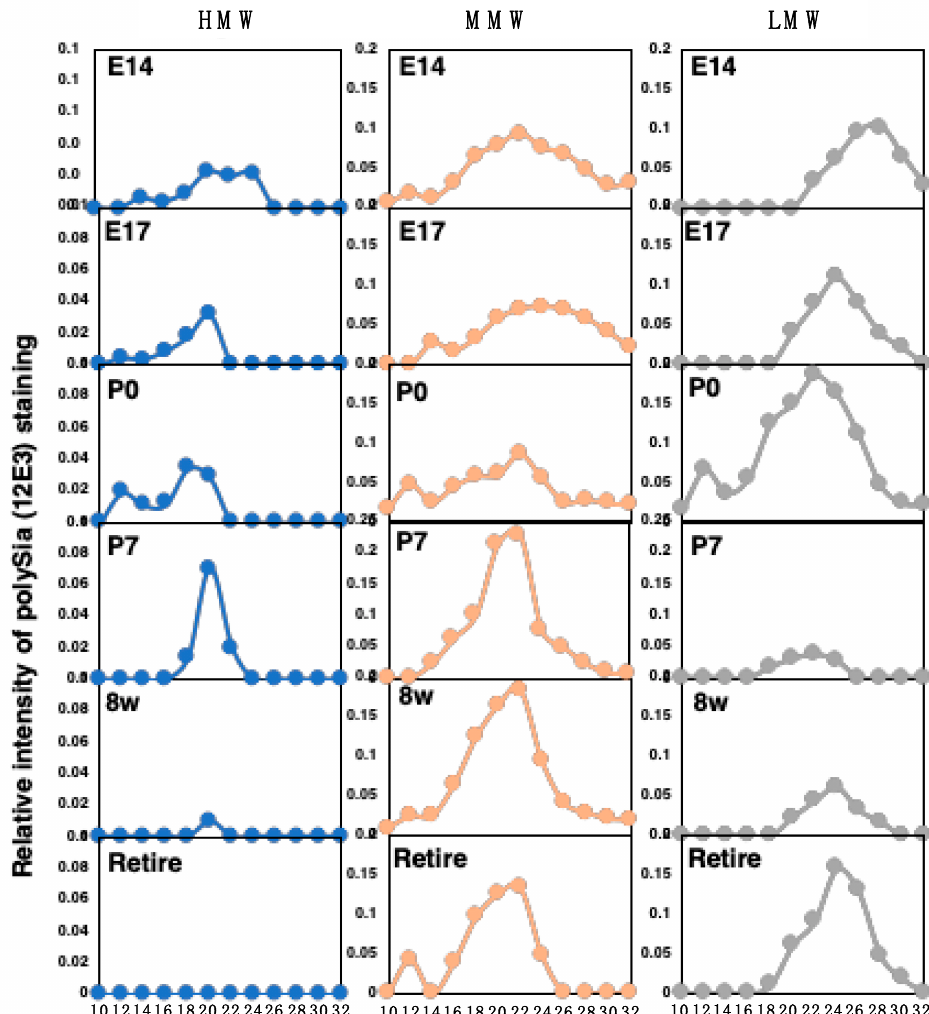
Figure 9. Gel filtration of polySia–NCAM derived from mouse brains at di ff erent developmental stages. Brain homogenates were analyzed by Sephacryl S-500 gel filtration chromatography. The relative intensity was calculated by the 12E3 staining of native PAGE, as shown in Figure S2. The staining was categorized into three molecular species: HMW (above 720 kDa), MMW (480–720 kDa), and LMW (less than 480 kDa), according to the staining area. The sum of the intensity of the immunostaining of the fractions was set to 1.0.